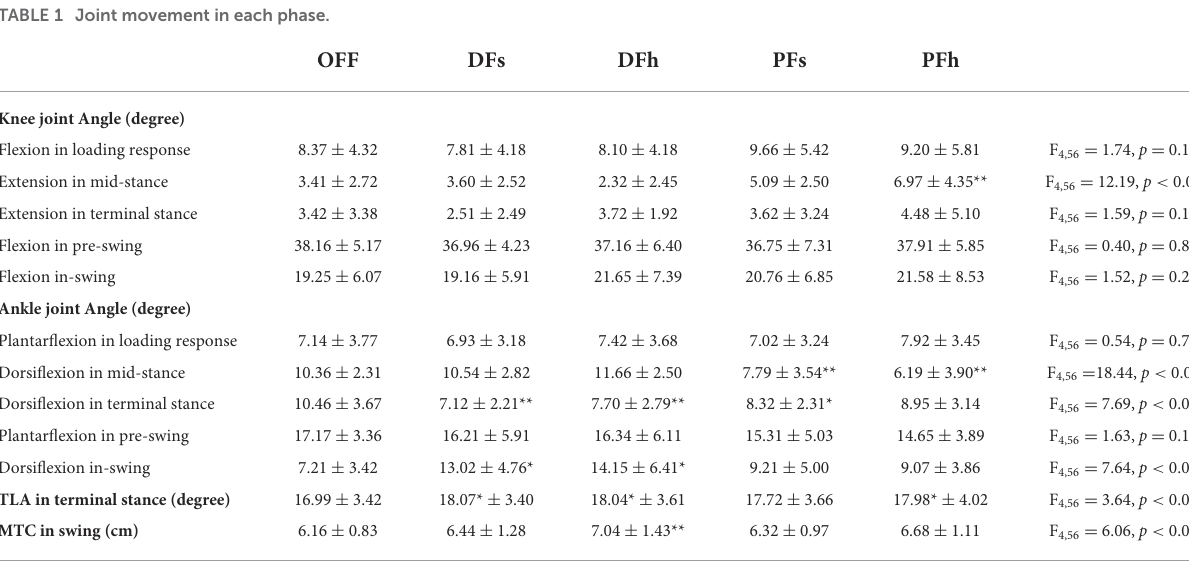
TABLE 1 Joint movement in each